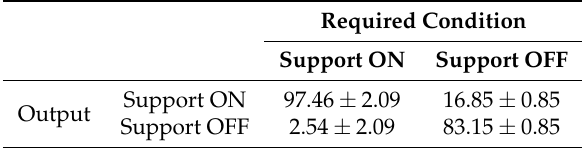
Figure 7. Example of control output for the support of the quasi-passive spinal exoskeleton. Shaded grey areas indicate when the support needs to be active. Highlighted trajectories represent the real-time output of the controller for support ON state. True positive activation of the support is denoted in green, False positive activation is denoted in red. Graph labels for the sections of standing are omitted for clarity. Table 1. Confusion matrix (mean ± s.d.) for support activation of